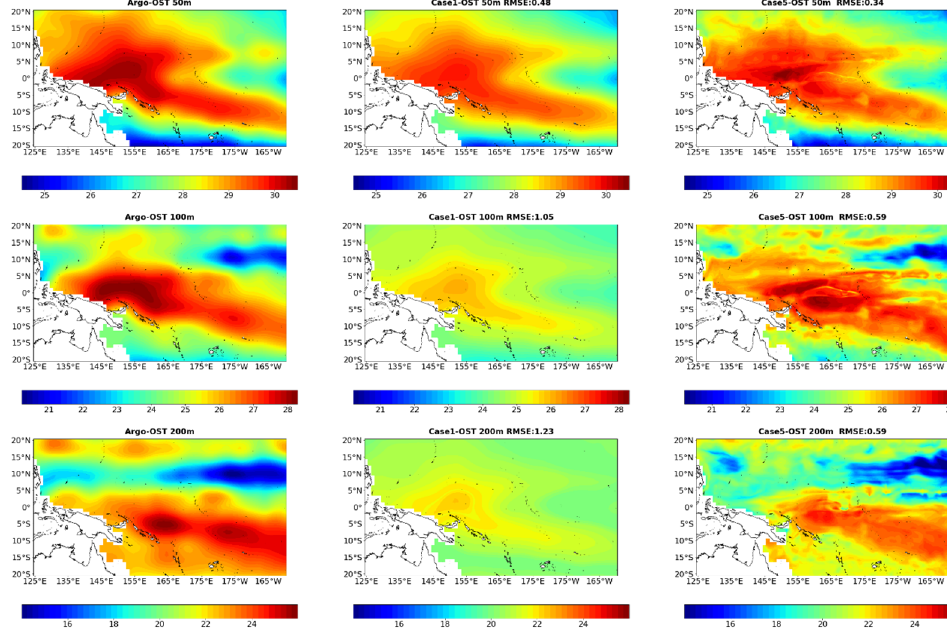
Figure 2. The OST (unit: °C) for November 2016 of (left) Argo data, (middle) Case 1, and (right) Case 5 at different depths. From top to bottom: 50 m, 100 m, and 200 m. Table 3. The RMSE values of Case 1 to Case 5 at 50 m, 100 m, and 200 m depths.